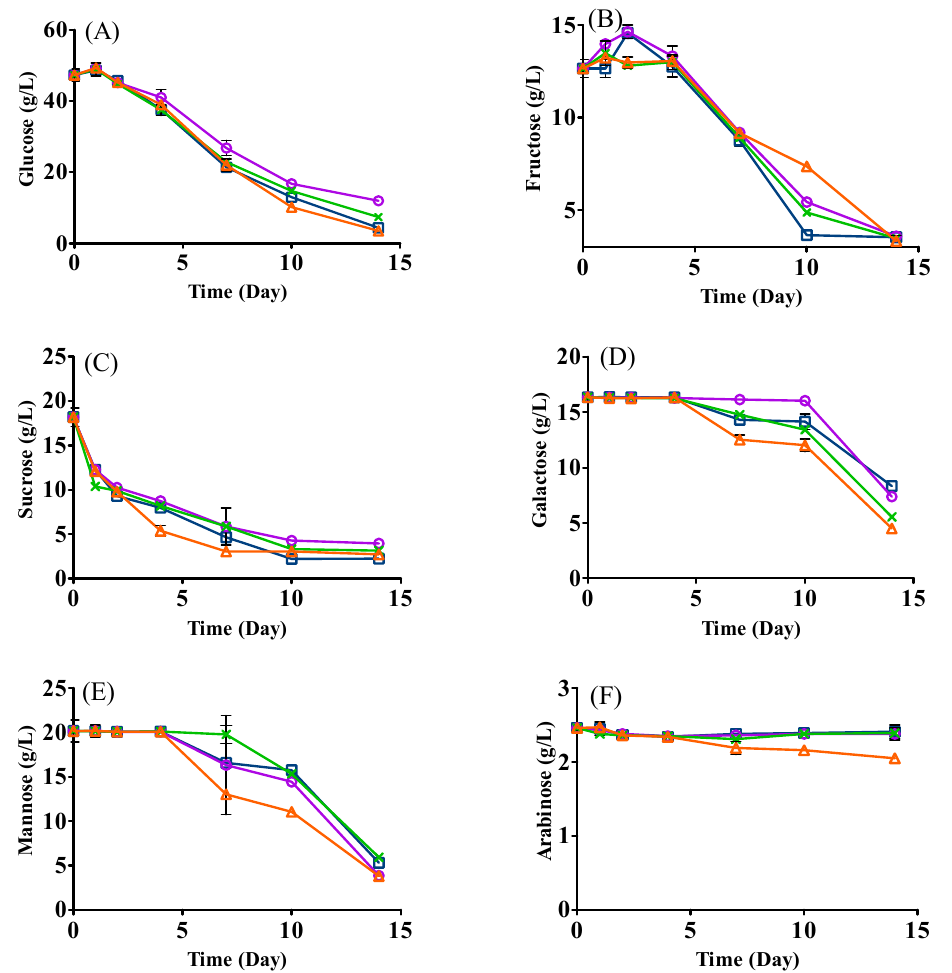
Figure 2. Changes in sugars (( A ), glucose; ( B ), fructose; ( C ), sucrose; ( D ), galactose; ( E ), mannose; ( F ), arabinose) in SCG hydrolysates fermented with L. thermotolerans and L. plantarum . LT ( □ ): mono-inoculation of L. thermotolerans Concerto; LP ( ○ ): mono-inoculation of L. plantarum ML Prime; LT+Co-LP (X): co-inoculation of L. thermotolerans Concerto and L. plantarum ML Prime; LT+Se-LP ( △ ): sequential inoculation of L. thermotolerans Concerto and L. plantarum ML Prime at day 4.